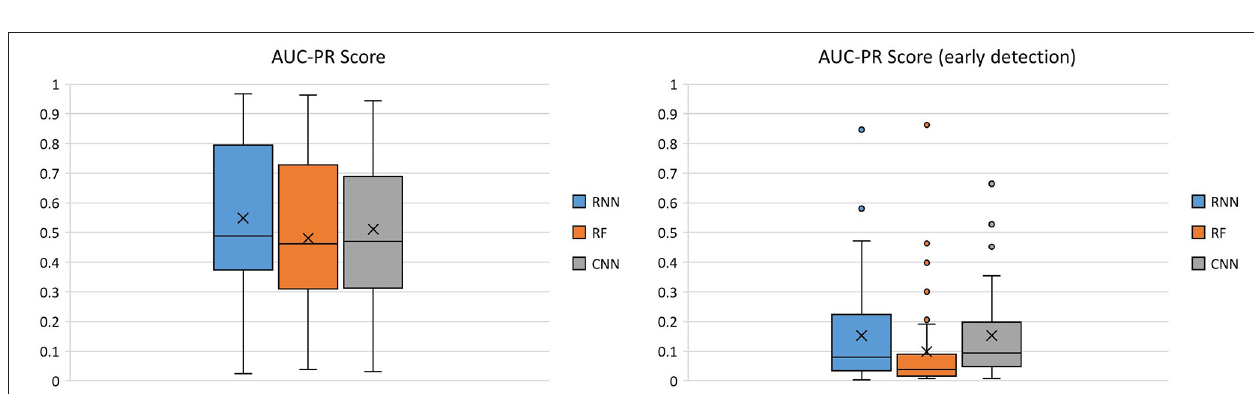
RF 0.929 (0.914) and CNN 0.916 (0.876). The average